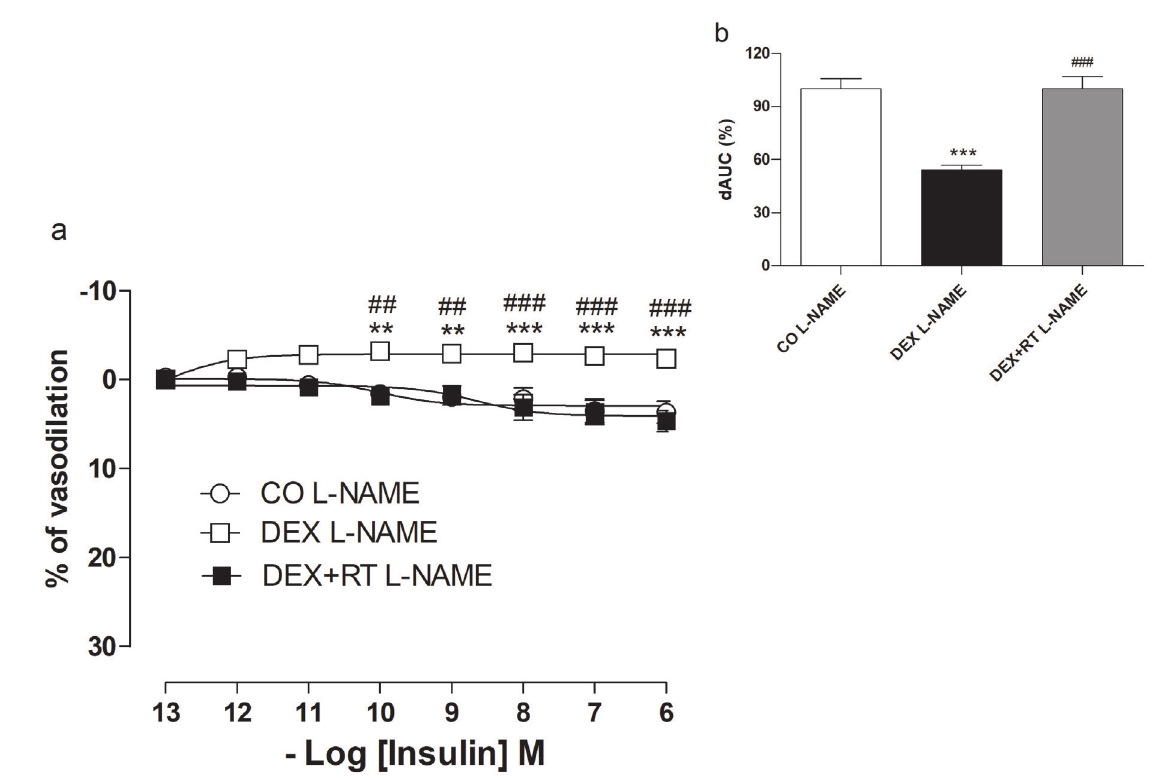
Figure 3. Cumulative concentration-response curve to insulin in intact segments obtained from the superior mesenteric artery of Wistar rats and pre-contracted with phenylephrine (1 μM) in the control (CO), dexamethasone-treated (DEX) and dexamethasone + resistance training (DEX+RT) groups, in the presence of L-NAME (100 μM) (a), and the difference in the area under the concentration–response curve (dAUC) for the response to insulin is shown for the CO, DEX and DEX+RT groups (b). The results are expressed as the mean ± SEM for 8–10 experiments in each group. *p< 0.05, **p< 0.01 ***p< 0.001, CO vs. DEX; # p< 0.05, ## p< 0.01, ### p< 0.001, DEX vs.